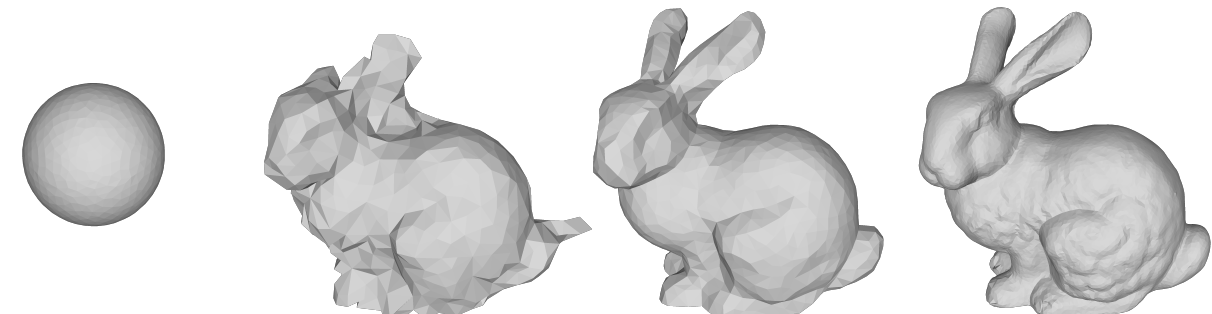
Figure 1. Starting from a sphere, our method reconstructs the Stanford Bunny [3] from images with low levels of noise. From left to right: Initial mesh (sphere), after 50 iterations, after 750 iterations and the converged result (1952 iterations). The final reconstruction has 13,780 vertices and a volume error ( ∆ V ) of 0.30% when compared to the ground truth (depicted in Figure